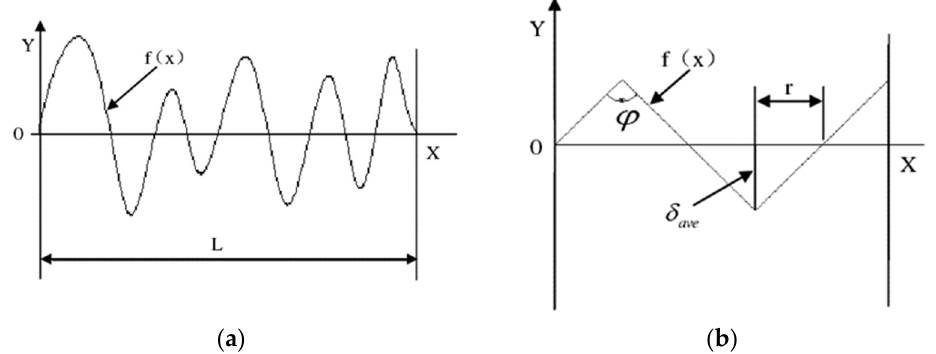
Figure 2. Schematic diagram of surface roughness: ( a ) Surface profile cross section, ( b ) Arithmetic mean deviation micro-element diagram.